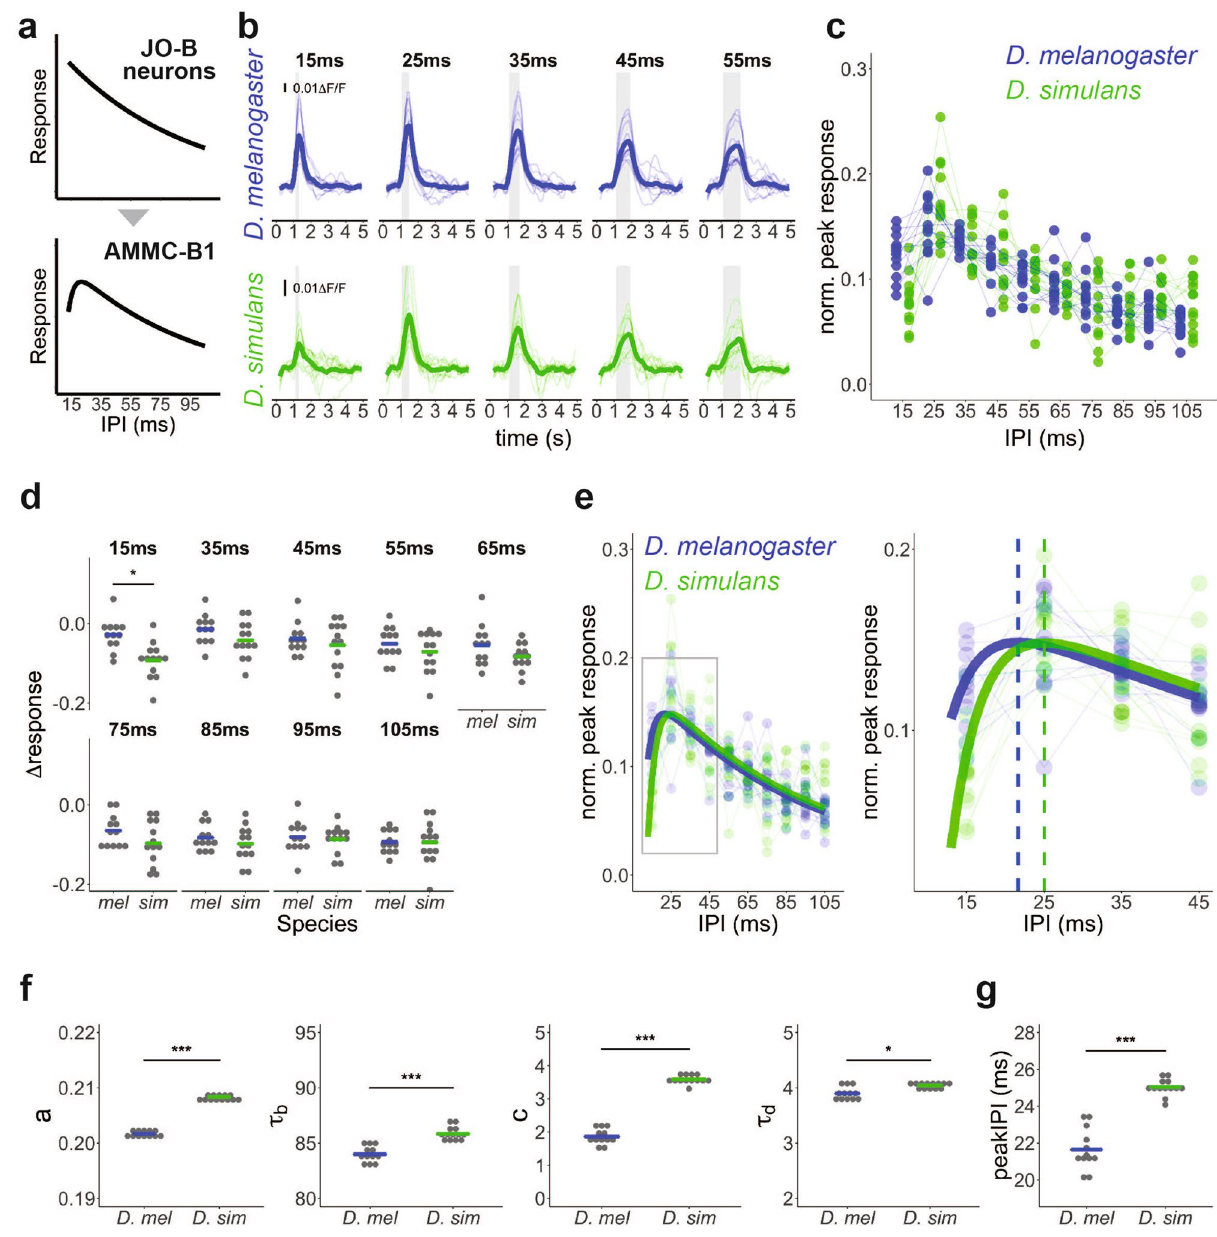
Figure 4. Interspecific comparison of IPI response properties of AMMC-B1 neurons. ( a ) IPI response properties of JO-B and AMMC-B1 neurons in D. melanogaster . Modified from Yamada et al. 31 . ( b ) Time traces of AMMC-B1 responses to artificial pulse songs with different IPIs. Responses to songs with 15–55 ms IPIs in D. melanogaster (blue) and D. simulans (green) are shown (See Supplementary Fig. S4 for all IPI data). Sound stimulus was comprised of 20 pulses for each IPI song (shaded gray area). Pulse songs were designed with a conspecific IPF (see Supplementary Fig. S1). Thin and bold lines show time traces of the response in each individual and the average of all individuals, respectively. ( c ) Normalized peak responses of AMMC-B1 neurons to pulse songs in D. melanogaster (blue) and D. simulans (green). Dots show normalized peak responses in each individual, where dots of the same individuals are connected with lines. ( d ) Differences from normalized peak responses to pulse song with 25-ms IPI (i.e., ∆responses) in D. melanogaster (blue) and D. simulan s (green). * p < 0.05; two-tailed t -test with Bonferroni correction. Crossbars show median and dots represent individual data. ( e ) Normalized peak responses fitted with Bayesian hierarchical model in D. melanogaster (blue) and D. simulans (green). Solid smooth lines represent fitted curves. Dots show normalized peak responses in each individual. Dots of the same individuals are connected with thin lines. Left: an overview of the fitting curve. Right: magnified view of short IPI range (left panel grey square). Dashed lines represent IPI where response peaks in D. melanogaster (blue) and D. simulans models (green), respectively. ( f ) Parameter values obtained from the fitted functions of D. melanogaster (blue) and D. simulans (green). Dots and crossbars represent the estimated parameters of fitting curves for each individual and all individuals, respectively. * p < 0.05, *** p < 0.001; Exact Wilcoxon rank sum test. ( g ) IPI at peak of individual fitting curve (See Supplementary Fig. S4) in D. melanogaster (blue) and D. simulans (green). Dots and crossbars indicate the estimated peak IPI of fitting curves for each individual and all individuals, respectively. *** p < 0.001; Exact Wilcoxon rank sum